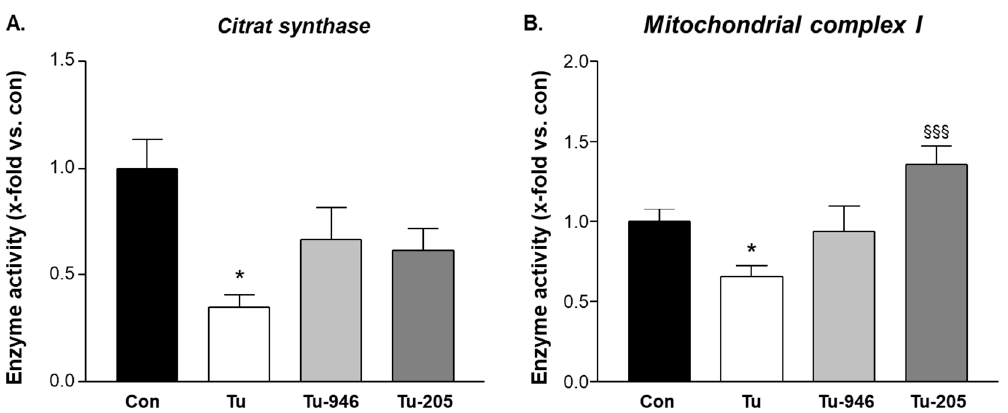
Figure 4. Citrate synthase and complex I activity in groups #1-4 ( A ). Melanoma outgrowth leads to depleted CS and complex 1 activity. Feeding with Myomed-946 (TU-946) or Myomed-205 (TU-205) reverses this reduction ( B ). Values are shown as mean ± standard error of the mean, * p < 0.05 vs. con; §§§ p < 0.001 vs. Tu.